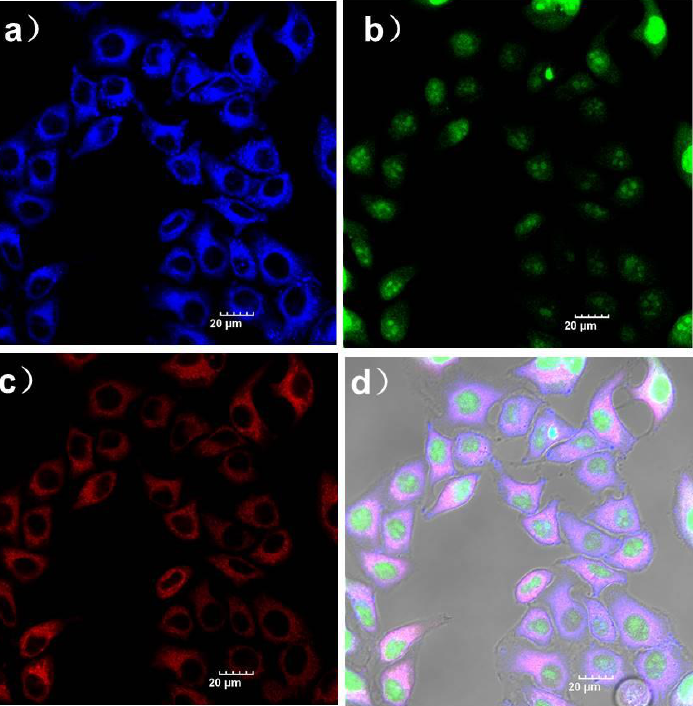
Figure 8. Cell localization experiment. ( a ) Cells were incubated with P for 30 min, and then Cu 2+ (10 µ M) for 30 min; ( b ) cells were incubated with P for 30 min, Cu 2+ (10 µ M) for 30 min, and Mito Tracker Red for 20 min at 37 ◦ C, subsequently; ( c ) cells were incubated with P for 30 min, Cu 2+ (10 µ M) for 30 min, and Mito Tracker Red for 20 min at 37 ◦ C, Green-488 for 10 min at 37 ◦ C subsequently; ( d ) overlay field image of cells in panels ( a – c ).